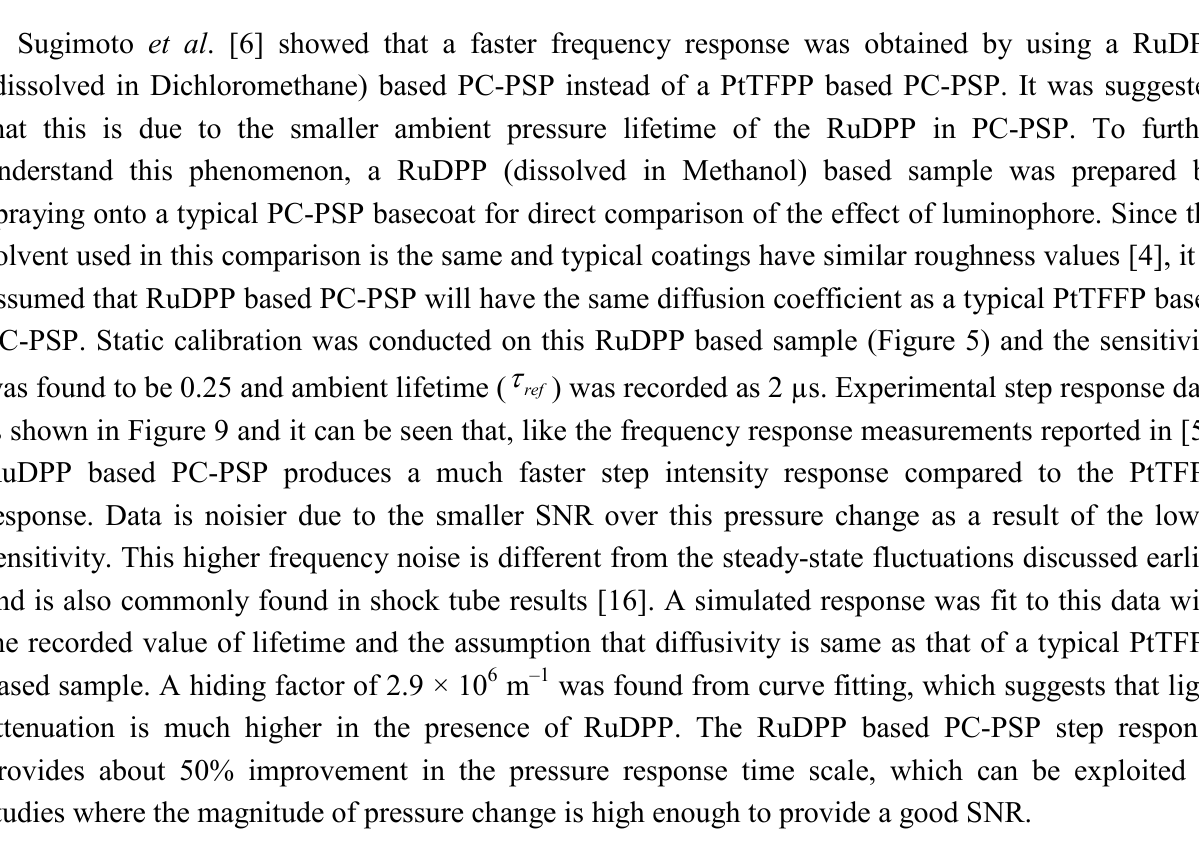
Figure 8. Measured and simulated intensity ( a ) and pressure ( b ) step responses for a typical sample and a rough